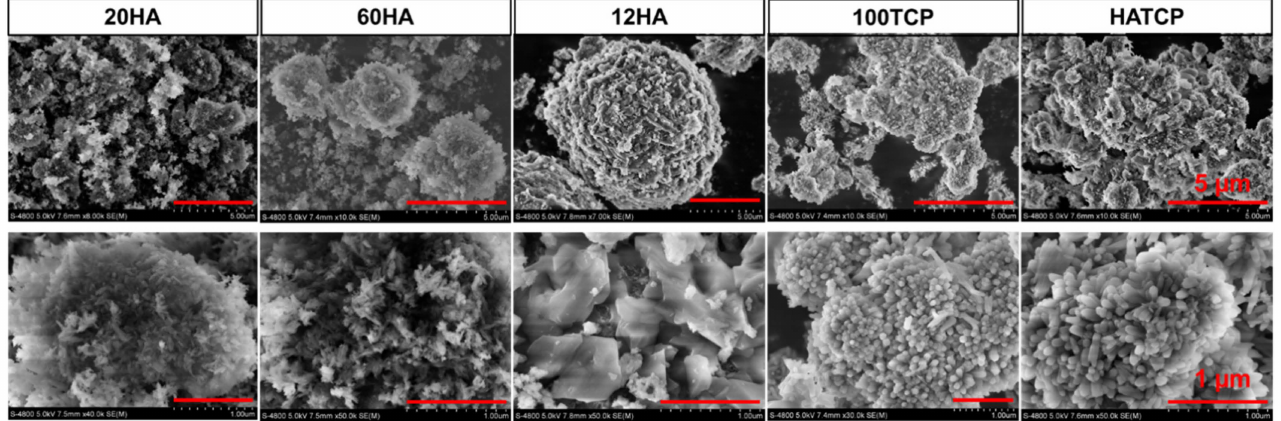
Figure 2. The SEM photos show the micromorphology of 20HA, 60HA, 12HA, 100TCP and HATCP biomaterials at two different magnifications. Bar above: 5 µ m; bar below: 1 µ